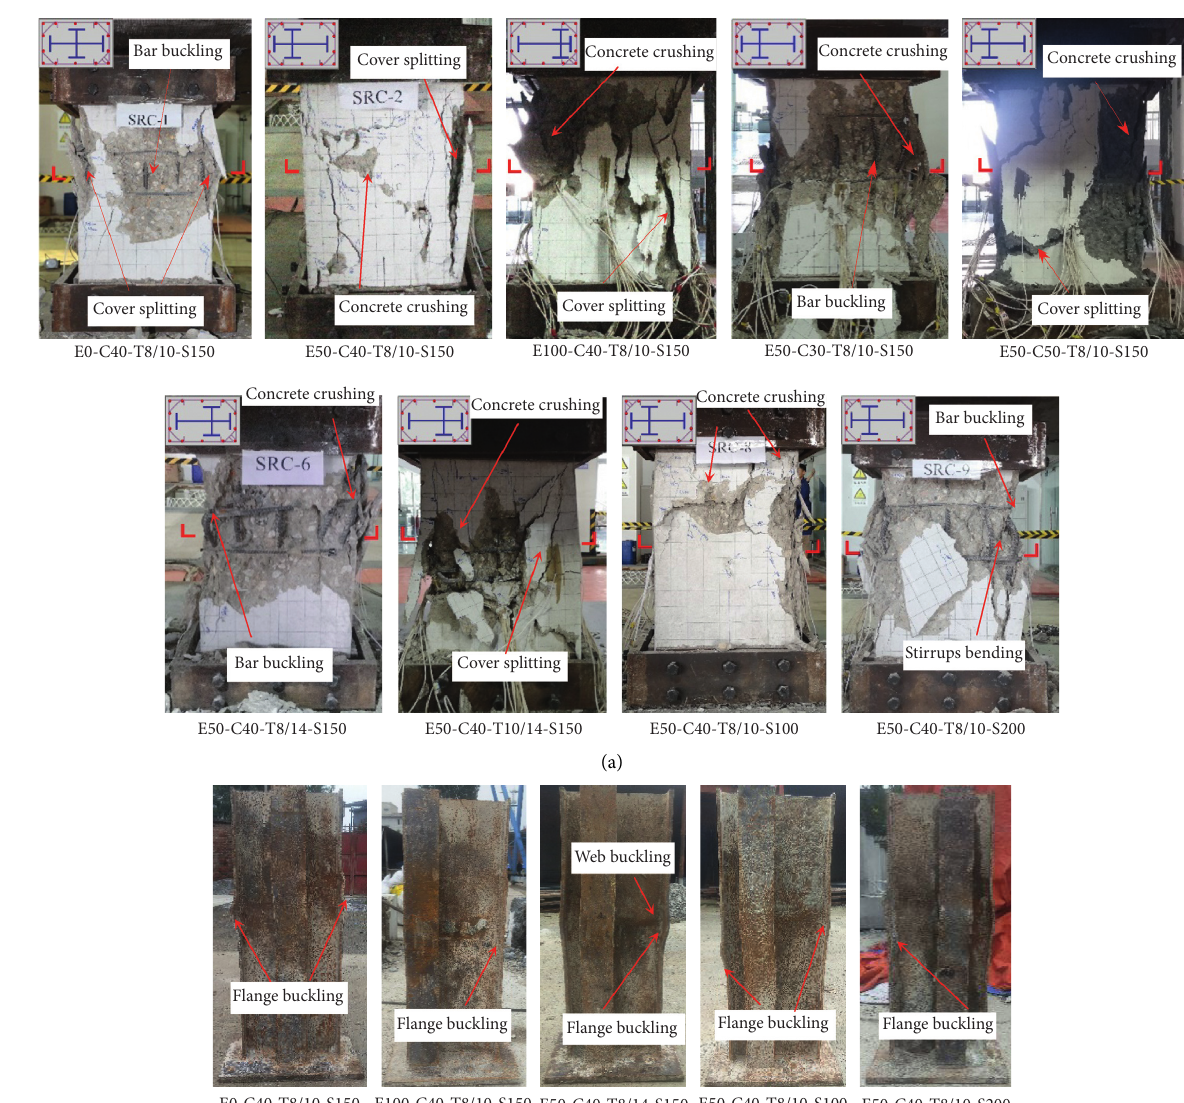
Figure 4: (a) Failure modes of specimens and (b) local buckling of the steel